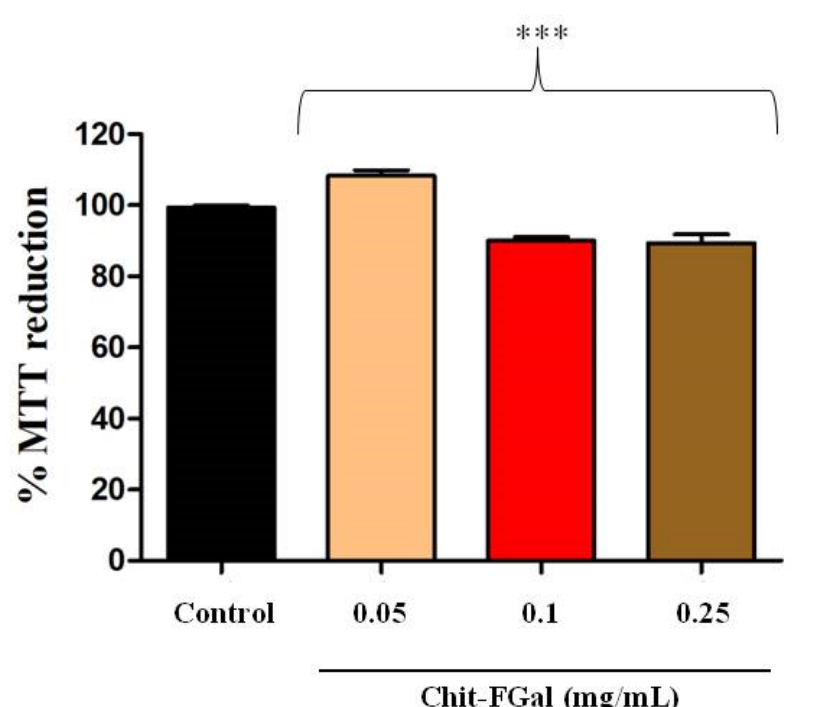
Figure 8. 3-(4,5-Dimethylthiazol-2-yl)-2,5-diphenyltetrazolium bromide (MTT) reducing activity of the 3T3 fibroblast cells incubated with Chit-FGal for 24 h. Values are expressed as the mean ± standard deviation at concentrations of 0.05, 0.1, and 0.25 mg/mL. *** indicates the significant difference between the control and samples ( p < 0.05).